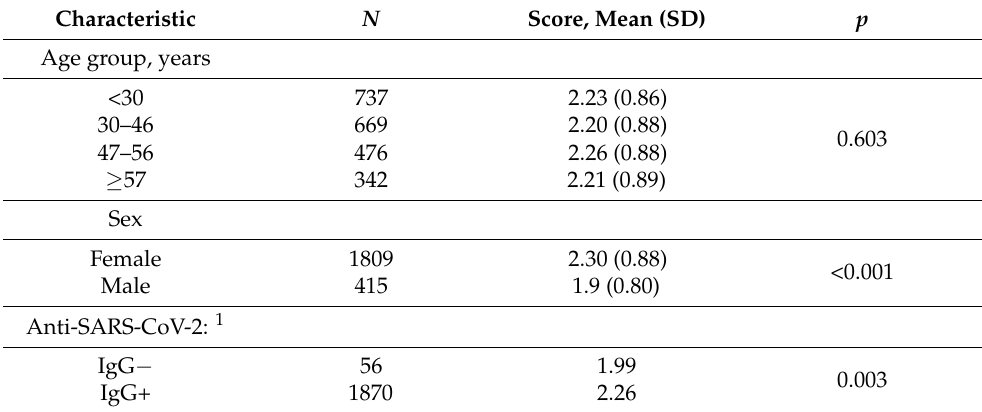
Table 6. Comparison of the mean intensity scores of all adverse reactions by age, sex and immune response.